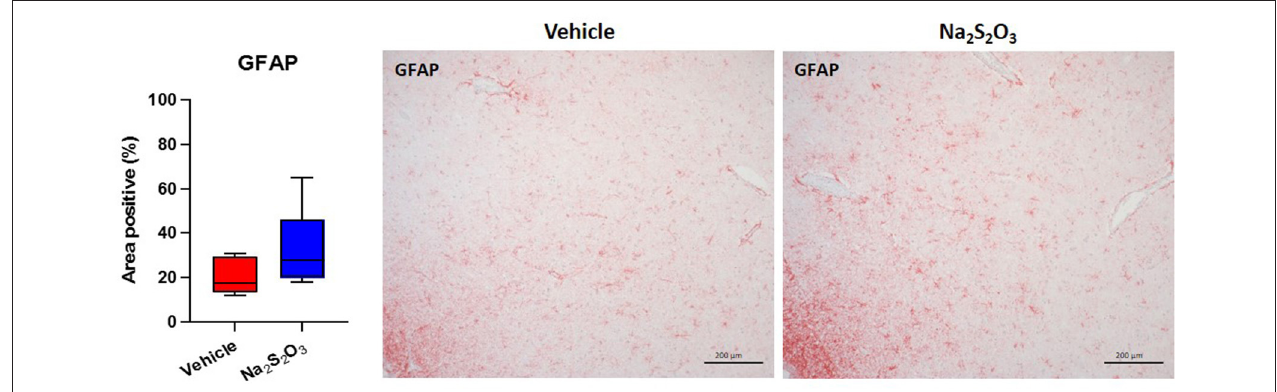
FIGURE 4 | GFAP in the porcine PVN. Quantification of the immunohistochemical stainings as positive percentage area in the PVN for GFAP (vehicle: n = 5; Na 2 S 2 O 3 : n = 8). Boxes represent the interquartile ranges with the median (black line), whiskers represent minimum and maximum values. Exemplary immunohistochemical pictures of GFAP in the PVN of vehicle and Na 2 S 2 O 3 treated animals (10X). PVN, paraventricular nucleus; GFAP, glial fibrillary acidic protein; Na 2 S 2 O 3 , sodium